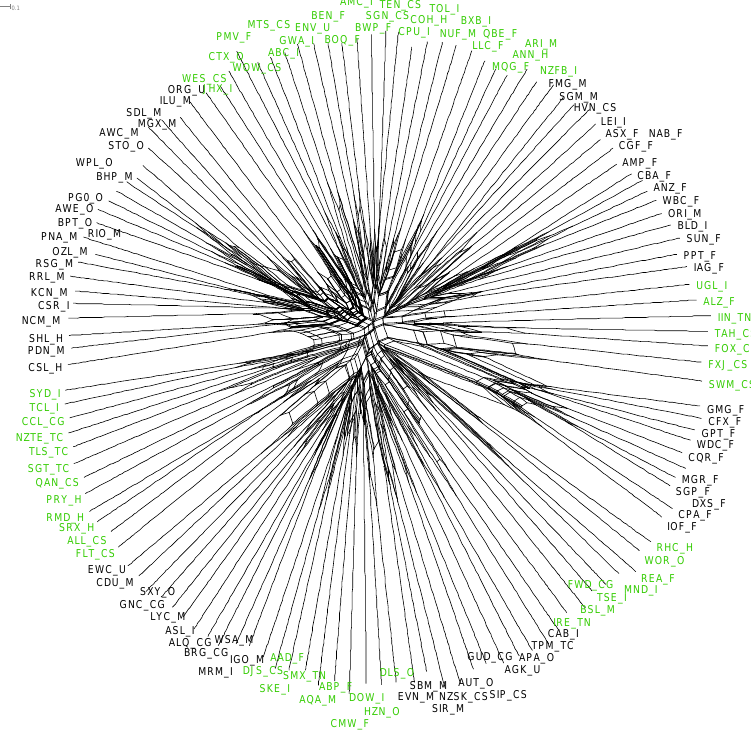
Figure 4. Period 3 neighbor-Nets splits graph with 10 clusters. A one or two letter code has been appended to each stock’s three letter ticker symbol to indicate what industry group it belongs to using the codes assigned in Table